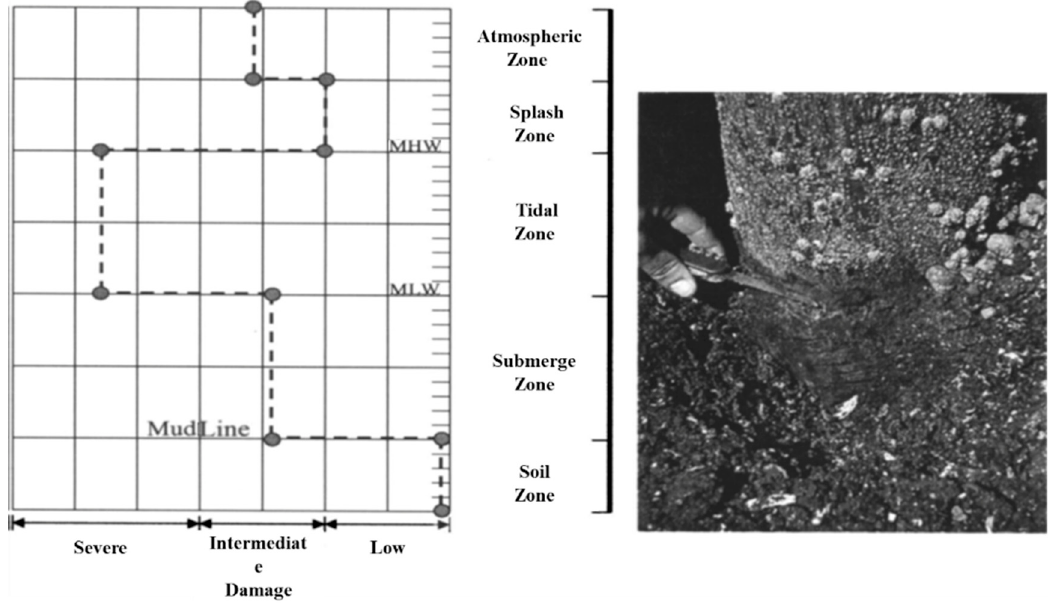
Figure 6. Photo of a submerged wood pillar at the mudline (right) and typical damage profile of wood pillar (left)